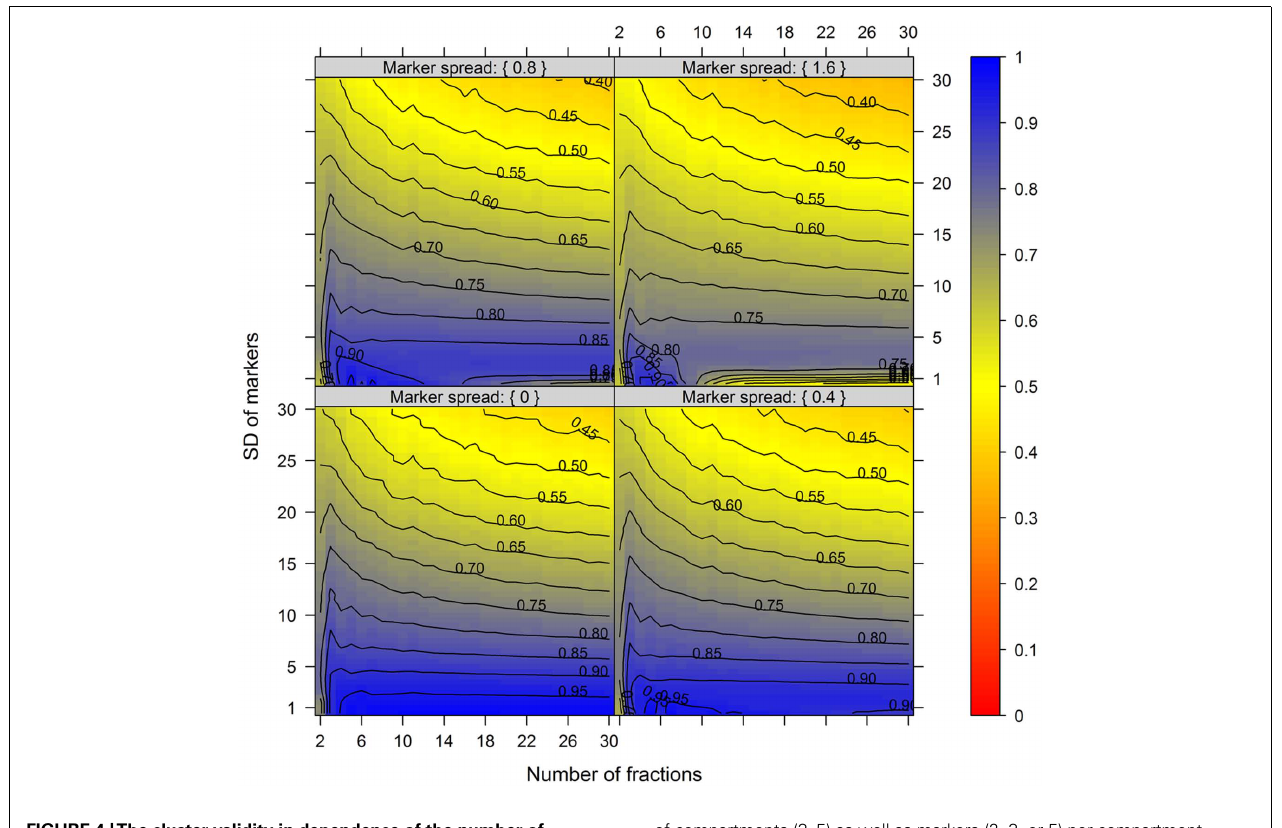
FIGURE 4 |The cluster validity in dependence of the number of collected fractions, the SD of markers, and the marker spread. While the SD modulates the between-compartmental separation, the marker spread modulates the within-compartmental cohesion (cf. Figure 3 ).The cluster validity index, estimated as mean–average of the Silhouette information and the Pearson’s matrix correlation, is depicted independent